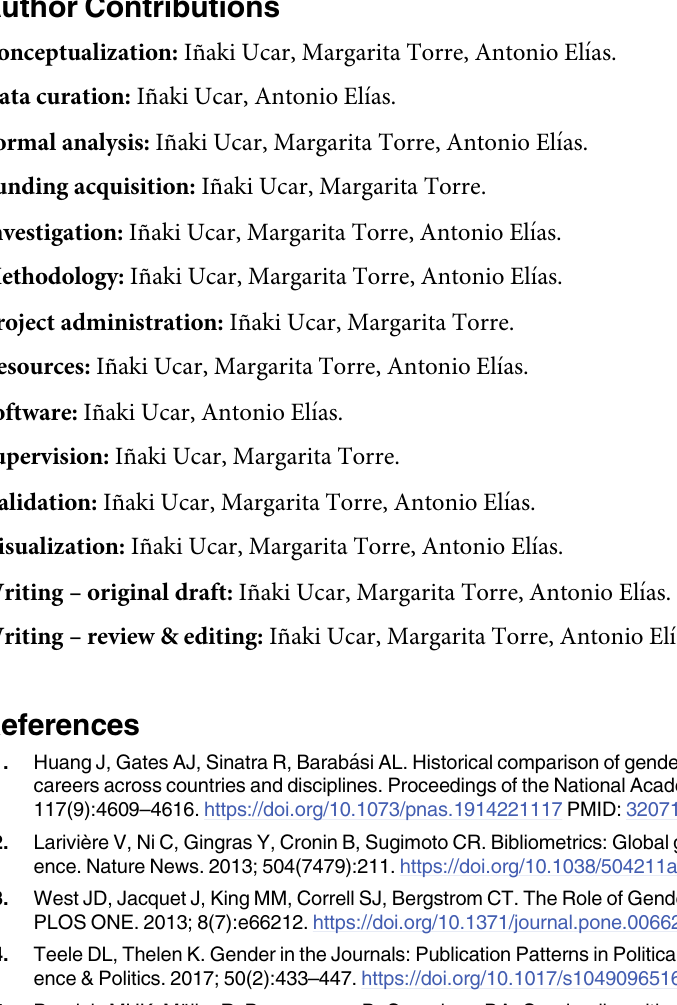
S2 Fig. Random intercepts for subcategories for all authors (1). Within each category, spe- cific subcategories develop their own trends. For example, we observe that high-energy and quantum physics are more masculinized than the average for all physics, while astrophysics- related research and bio-medical physics are more feminized. S1 Table. Initial composition of the dataset. Raw number of subcategories and preprints per category prior to any cleaning or pre-processing step. S2 Table. Manual adjustments for SocArXiv. As detailed in Methods, the large number of tags added to PsyArXiv and SocArXiv documents required a separate methodology for pre- print categorization. As a final step of such methodology, SocArXiv also required manual recoding of the subcategories listed